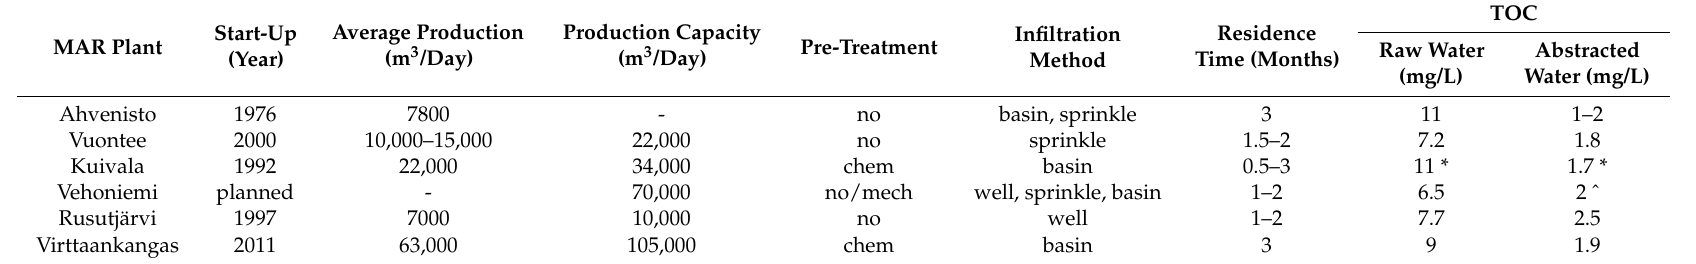
Table 1. Key figures of the studied MAR